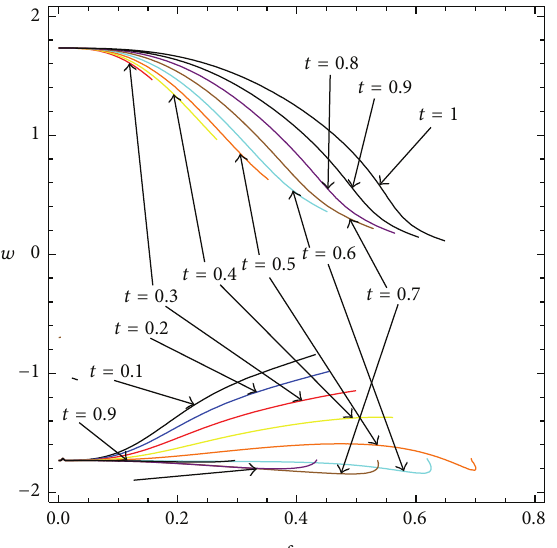
Figure 3: Families of central configuration in the case of isosceles trapezoid for values of 𝑡 ∈ (0, 1) . The various lines correspond to values of 𝑡 as